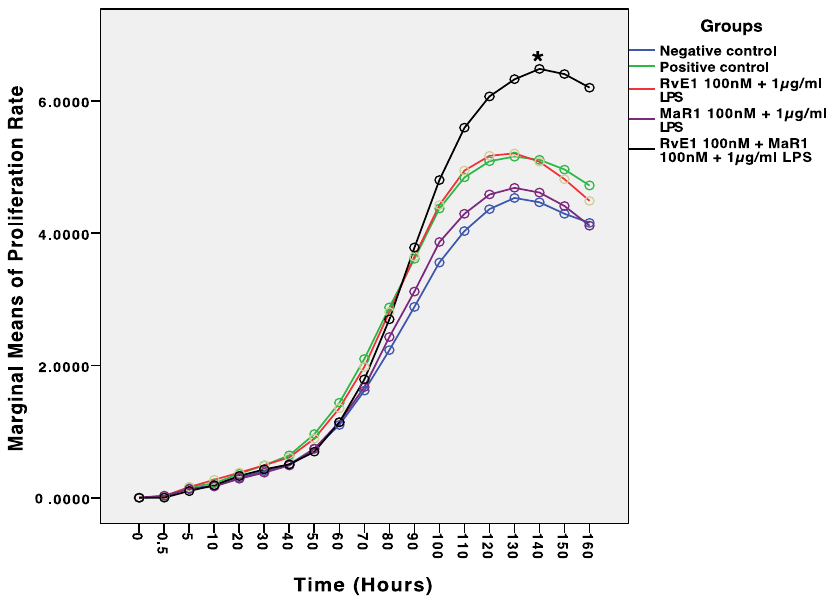
Figure 1. Comparison of mean proliferation values among the five study groups across different time points. The proliferation and viability assays experiments were repeated three times ( n = 3) and the average values used to confirm the findings. The proliferation rate of * Group-5 (RvE1 + MaR1 + LPS) was significantly higher than the other four groups ( p ≤ 0.0001).